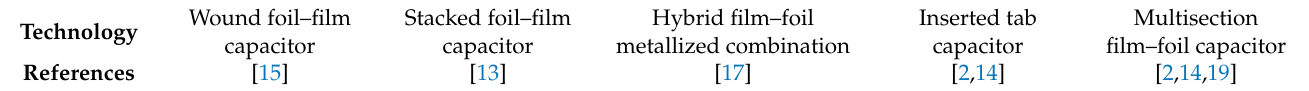
Table 4. Main review articles focusing on foil capacitor technologies.